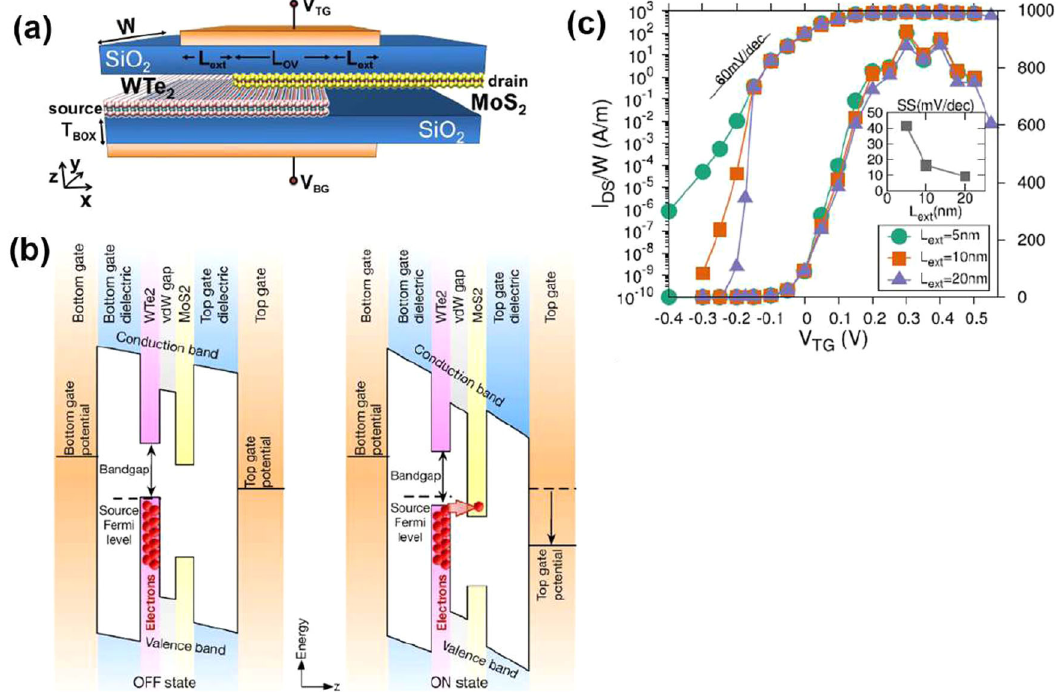
Fig. 23 Simulation Report of Nanoscale 2D vdW-TFET. a Device schematics, b on-state/off-state band alignments in MoS 2 /WTe 2 vdW hetero- junction, transfer characteristics for different c MoS 2 /WTe 2 vdW hetero-junction lengths, adapted with permission from 116 . Copyright (2016)